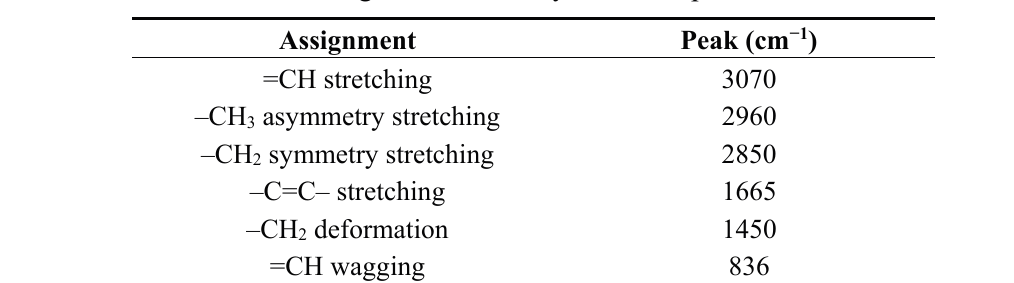
Table 1. Assignment summary of FTIR spectra of LNR.